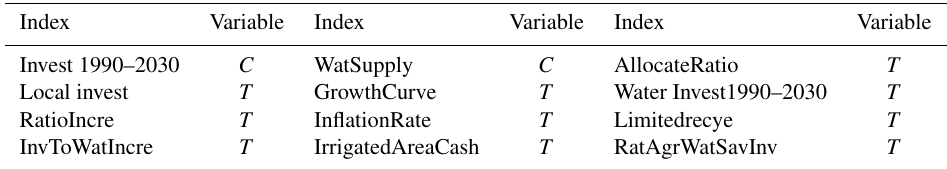
Table 1. The regional variable of evaluating index system for Zoucheng.